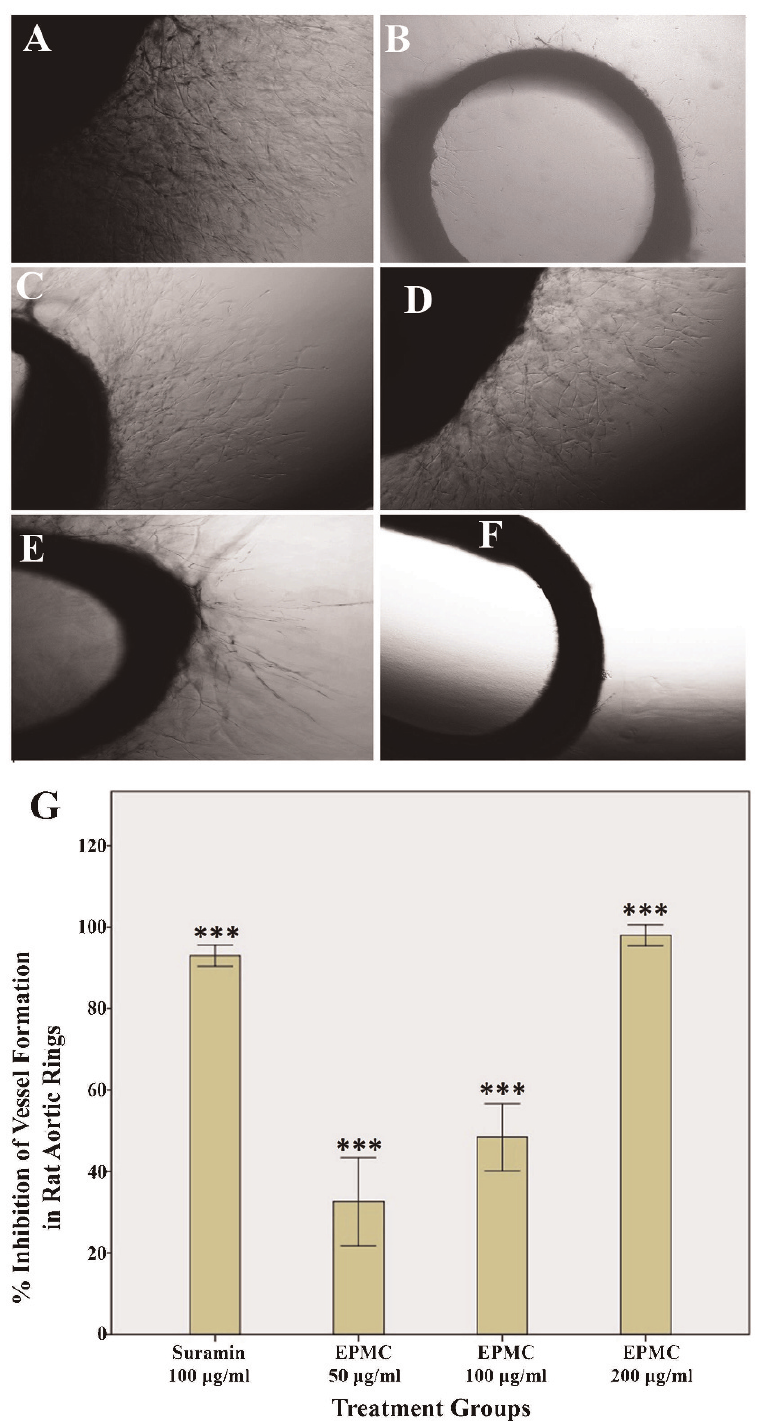
Figure 2 - Photomicrograph images of vascular growth in rat aortic rings, which were taken on the 5 th day of the experiment using an inverted phase-contrast microscope at 4 6 magnification. A ) Control rings are shown. B ) Rings treated with suramin 100 m g/ml are shown. C, D, E, and F ) Rings treated with 25, 50, 100, and 200 m g/ml ethyl- p -methoxycinnamate (EPMC) are shown. G ) Graphical representation of the inhibitory effect of EPMC on blood vessel growth in rat aortic rings at concentrations of 50, 100, and 200 m g/ml. The result is compared with the standard reference, suramin. All values are represented as the mean ¡ SEM ( n =10), and *** indicates significant differences of p , 0.001 compared with the control-treated